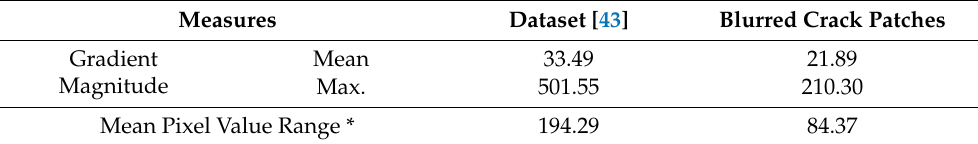
Table 2. Comparison of the crack patch datasets in terms of clarity and sharpness.